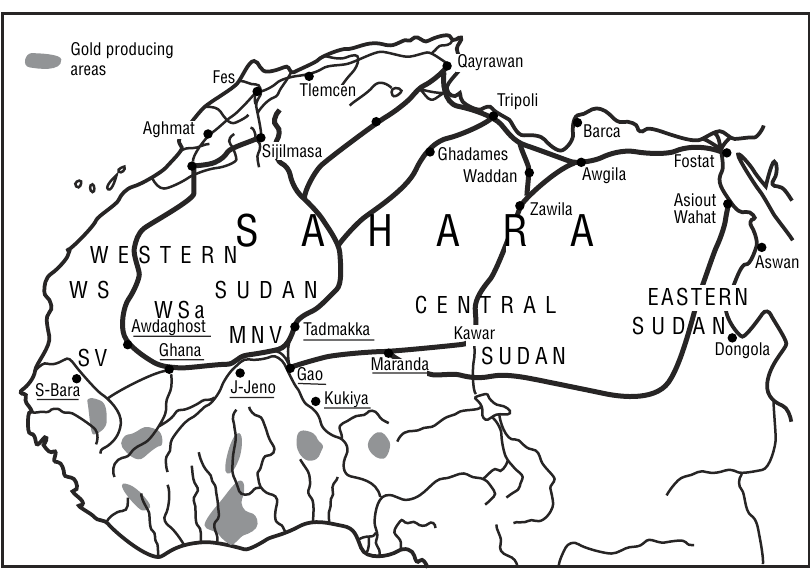
Figure 1 – Sudanic Africa and Interaction Networks (8t–10t Century A.D.)